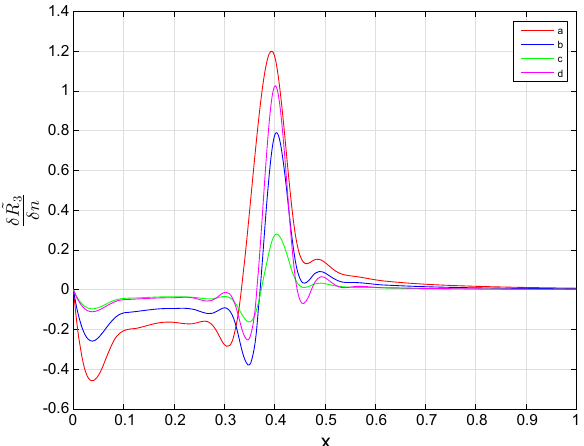
as a function of x for n